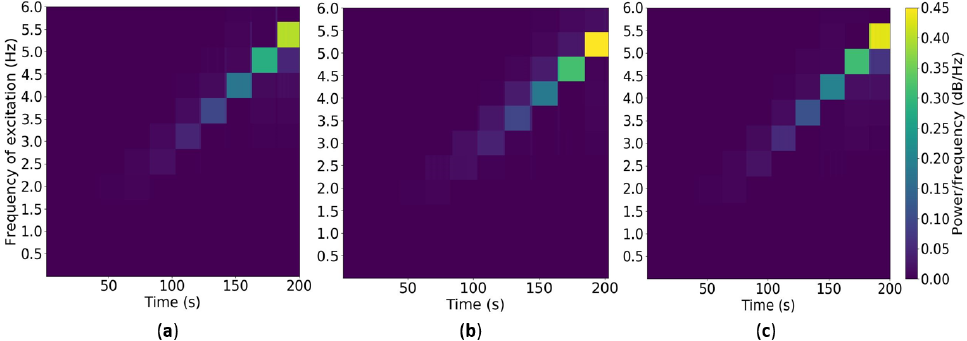
Figure 18. Spectrograms for the 0.75 cm displacement frequency chirp: ( a ) PCB L74 spectrogram. ( b ) ADXL355 RBP1 spectrogram. ( c ) ADXL355 RBP4